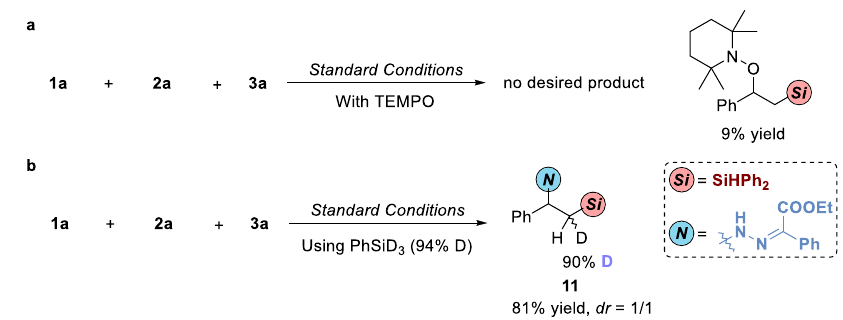
Fig. 7 Radical trapping and Deuterium-labeling experiments. a Radical trapping experiment using TEMPO as radical trapping reagent. b Deuterium- labeling experiment using PhSiD 3 as deuterated reagent.